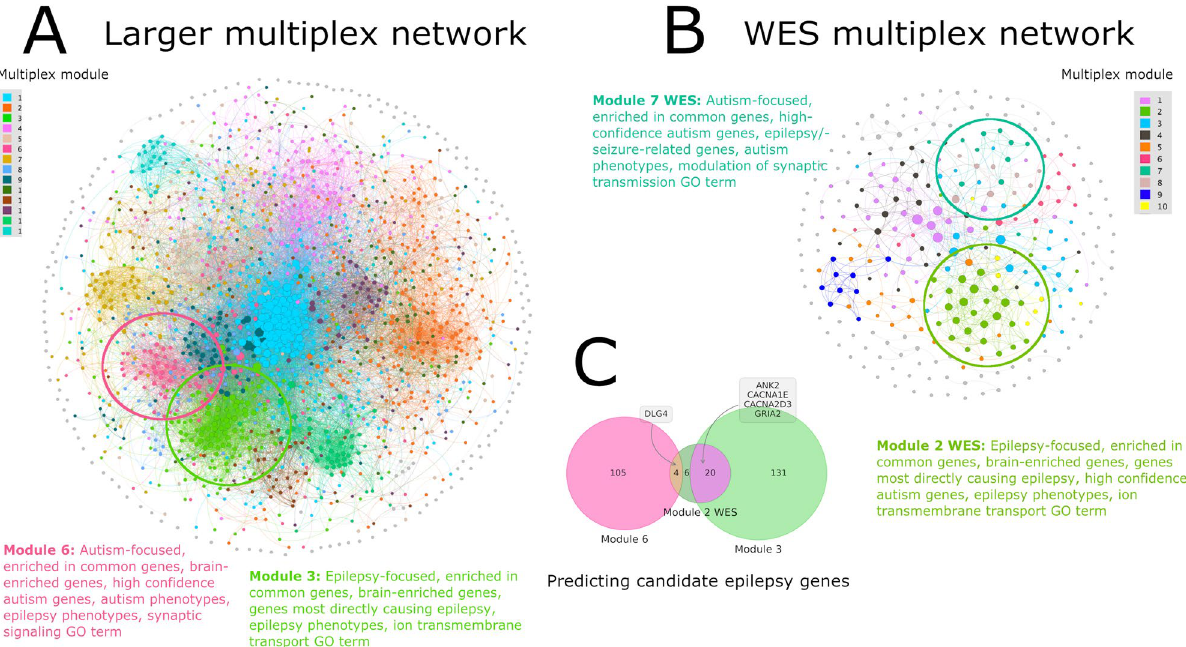
Figure 1. Summary of study findings. ( A ) A network of all 1707 epilepsy- and autism-associated genes from Wang et al. (2017) 10 and SFARI 60 and ( B ) A network of 294 epilepsy and autism genes from WES studies 38,61 . The edges represent the union of edges from the PPI network layer and phenotype network layer of the multiplex network. The color of a node represents the module it belongs to in the multiplex network and the size of the node is relative to its degree in the network. Key modules identified in the study are annotated. The network plots were generated using Gephi version 0.9.2, a graph visualization software. ( C ) The five autism-specific genes (i.e. not listed in Wang et al. (2017) 10 ) in module 3 and 6 of the larger multiplex network that overlap with epilepsy-focused module 2 of the WES network are predicted candidate epilepsy